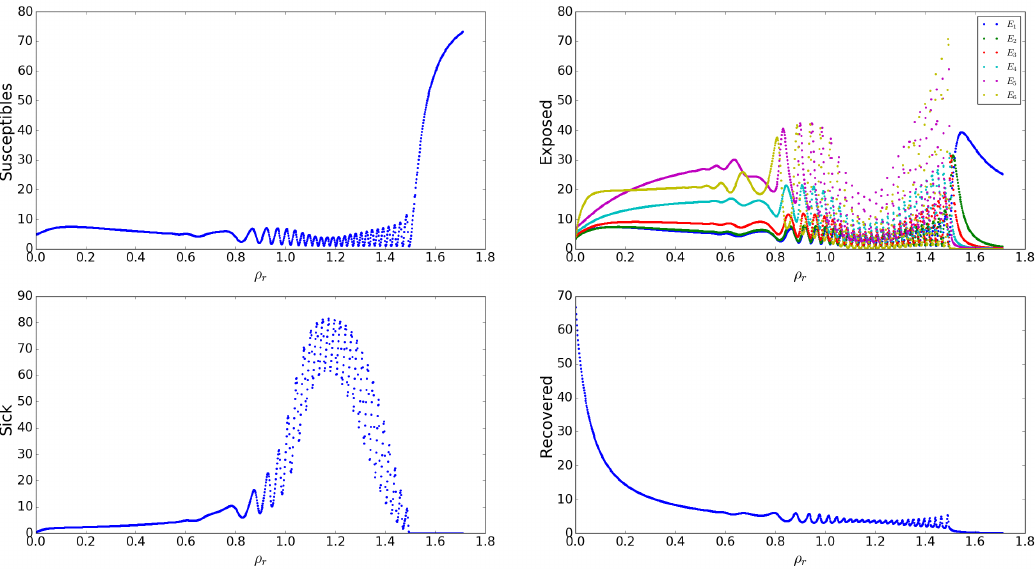
(cid:48) s (represented here by ρ r as in (A6)). i